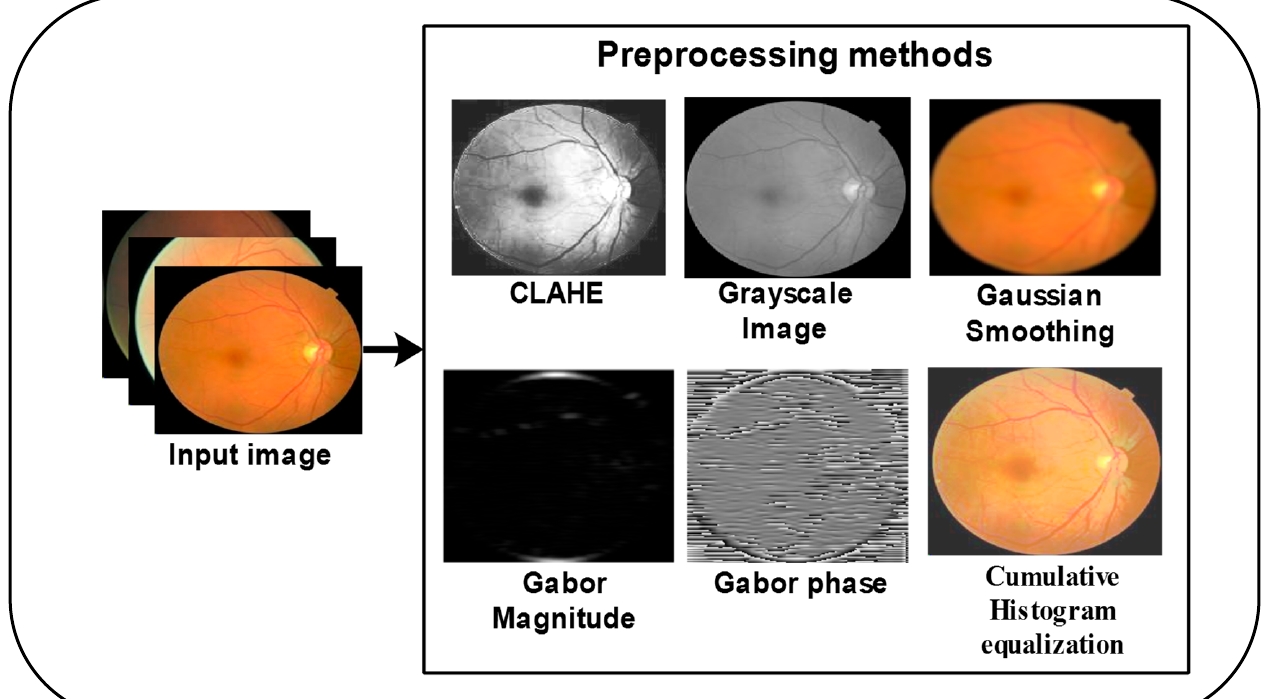
Figure 5. Image preprocessing techniques applied on Messidor dataset [54] .